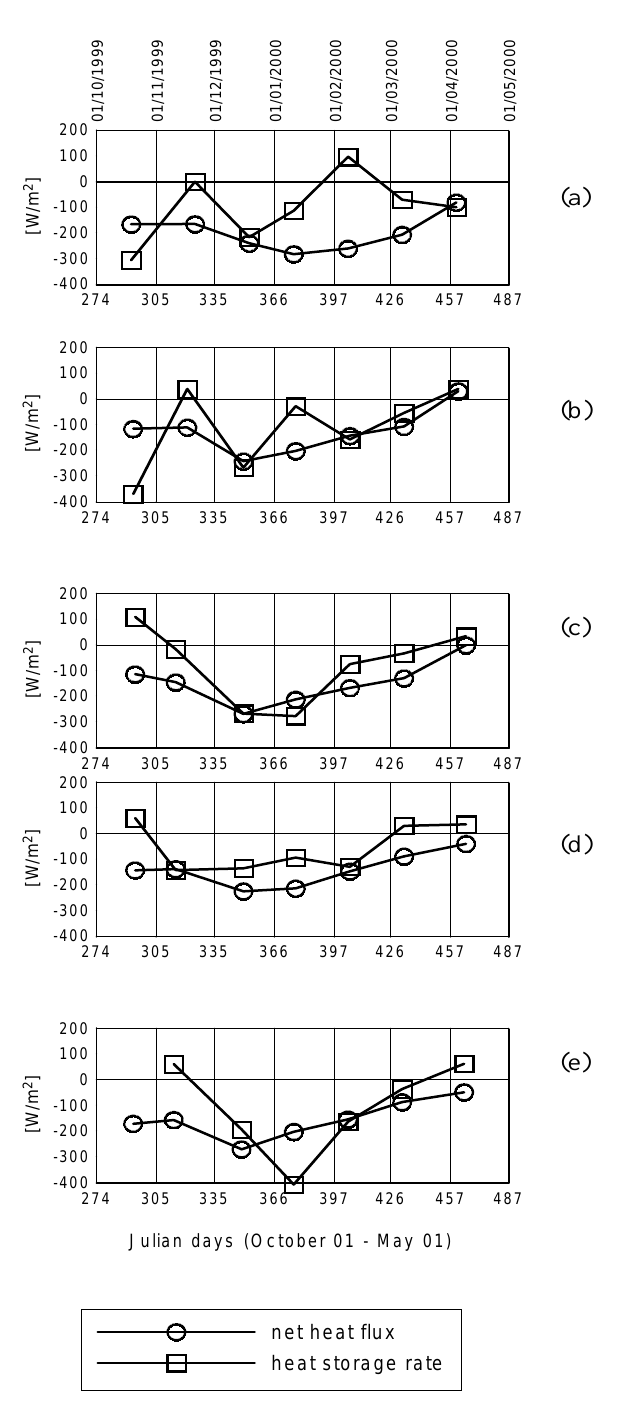
Fig. 5. Time averaged net heat flux at the air-sea interface and the heat storage rate in the upper layer for the period between 27 September 1999 and 15 April 2000 at a monthly time scale: in the southern Adriatic (a) , in the NW Ionian (b) , in the southern Tyrrhenian Sea (c) , in the northern Tyrrhenian Sea (d) , and in the Ligurian Sea (e) . The heat storage rate refers to the water column either between 5 and 450m (a and b), or between 5 and 330m (c, d, and e). The time scale refers to the upper integral limit t 2 from Eq. (3) in the